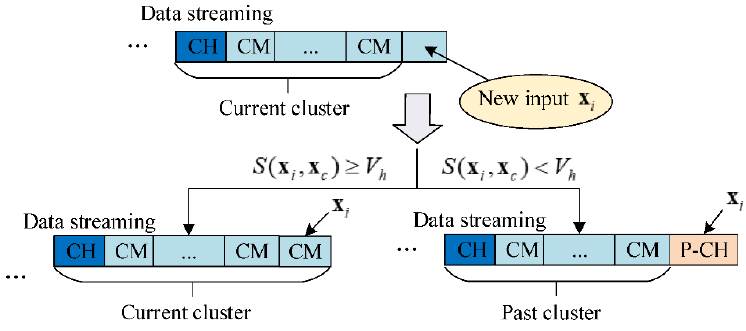
Figure 3. Data streaming clustering process for a new input.